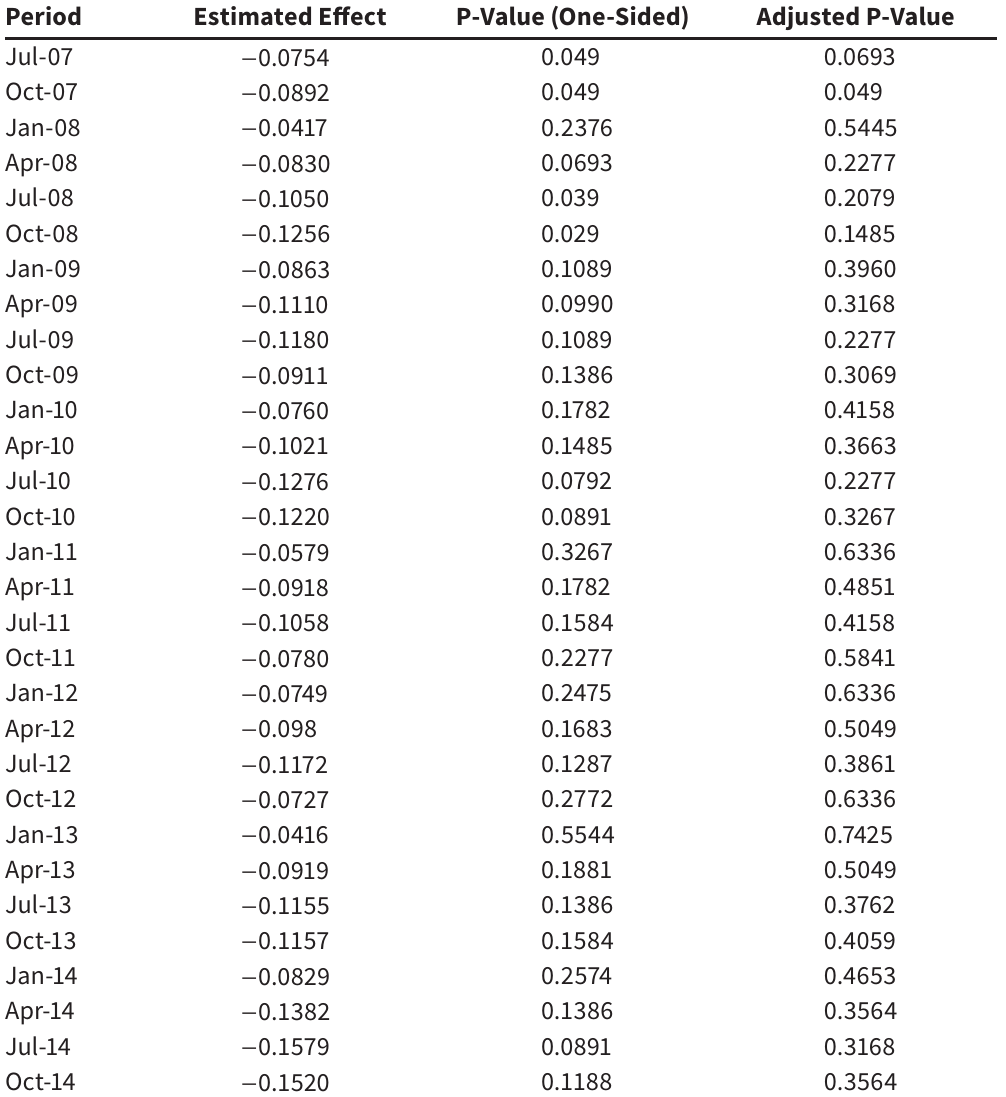
Table S9 Treatment Effects and Significance for Log Employment/Population Ratio in Puerto Rican Accommodation and Food Industry (USA Donors) (Truncated to Quarterly for